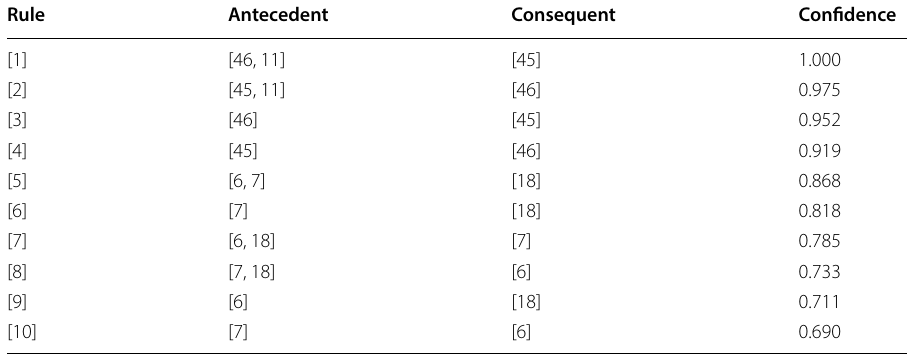
Table 3 Top 10 generated association